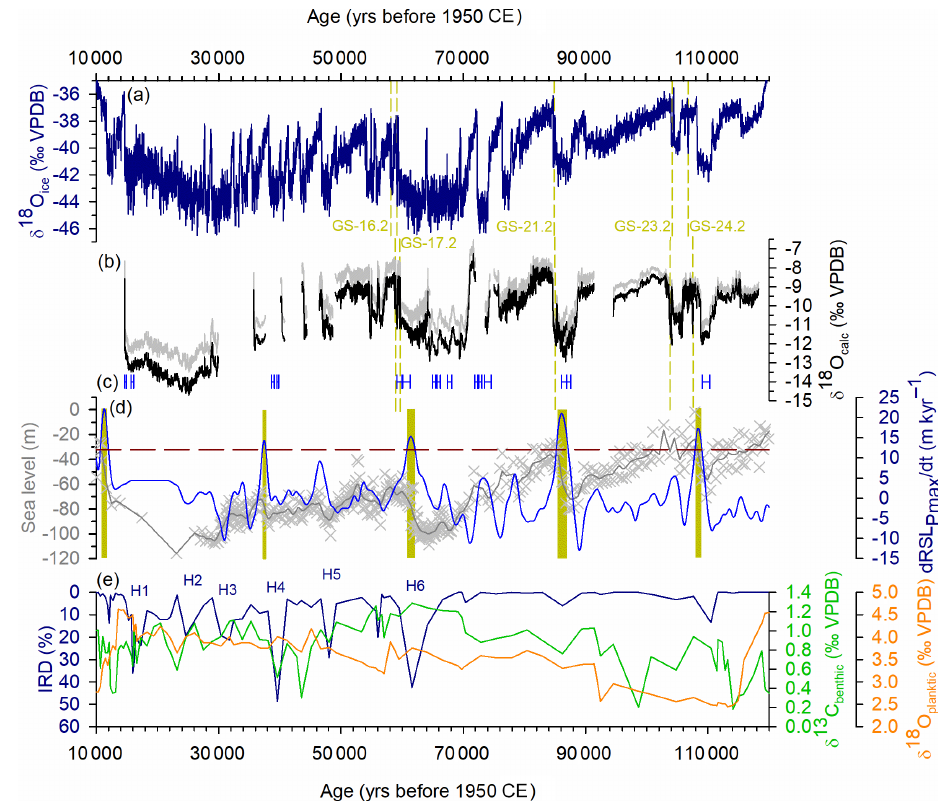
Figure 8. (a) NGRIP δ 18 O ice on GICC05 modelext (Wolff et al., 2010). (b) NALPS19 δ 18 O calc uncorrected for variability in ocean δ 18 O (grey), corrected for variability in ocean δ 18 O (black). (c) Growth periods in Brazilian speleothem (dark blue; Wang et al., 2004). Centennial- scale cold reversals of 16.2, 17.2, 21.2, 23.2, and 24.2 are highlighted as vertical dashed yellow bars. (d) Sea-level variability (Grant et al., 2012). Relative sea-level data (grey crosses). Maximum probability relative sea level (grey line). Rate of sea-level change (blue line). Rate of 12mkyr − 1 indicated by horizontal red line. Peaks of sea-level change in excess of 12mkyr − 1 indicated by yellow bars. (e) Ice-rafted debris (dark blue), benthic δ 13 C (green), and planktic δ 18 O (orange) from ODP980 on the Hulu U–Th age scale (McManus et al., 1999; Barker et al.,